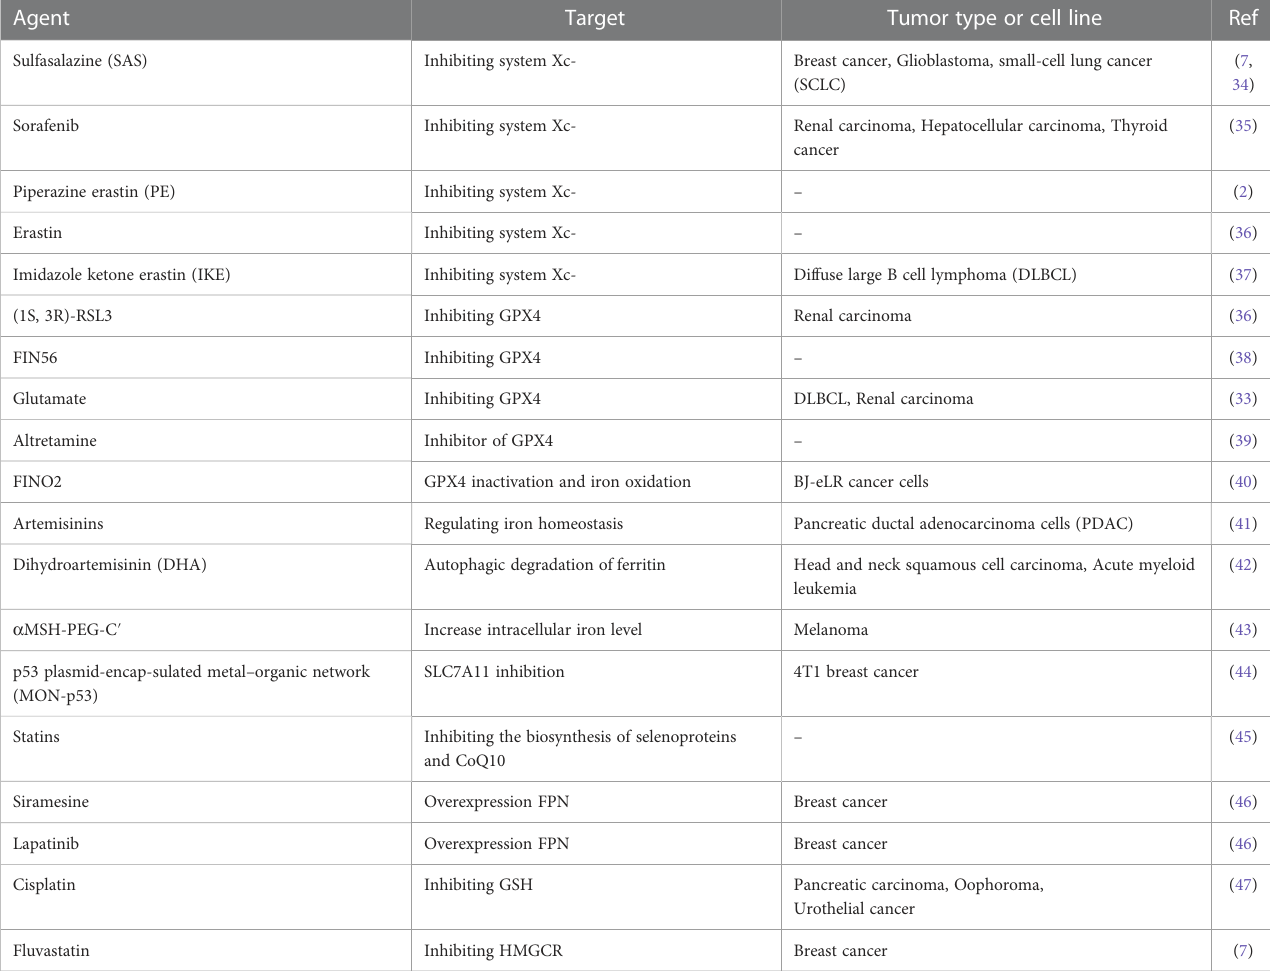
TABLE 1 Summary of ferroptosis